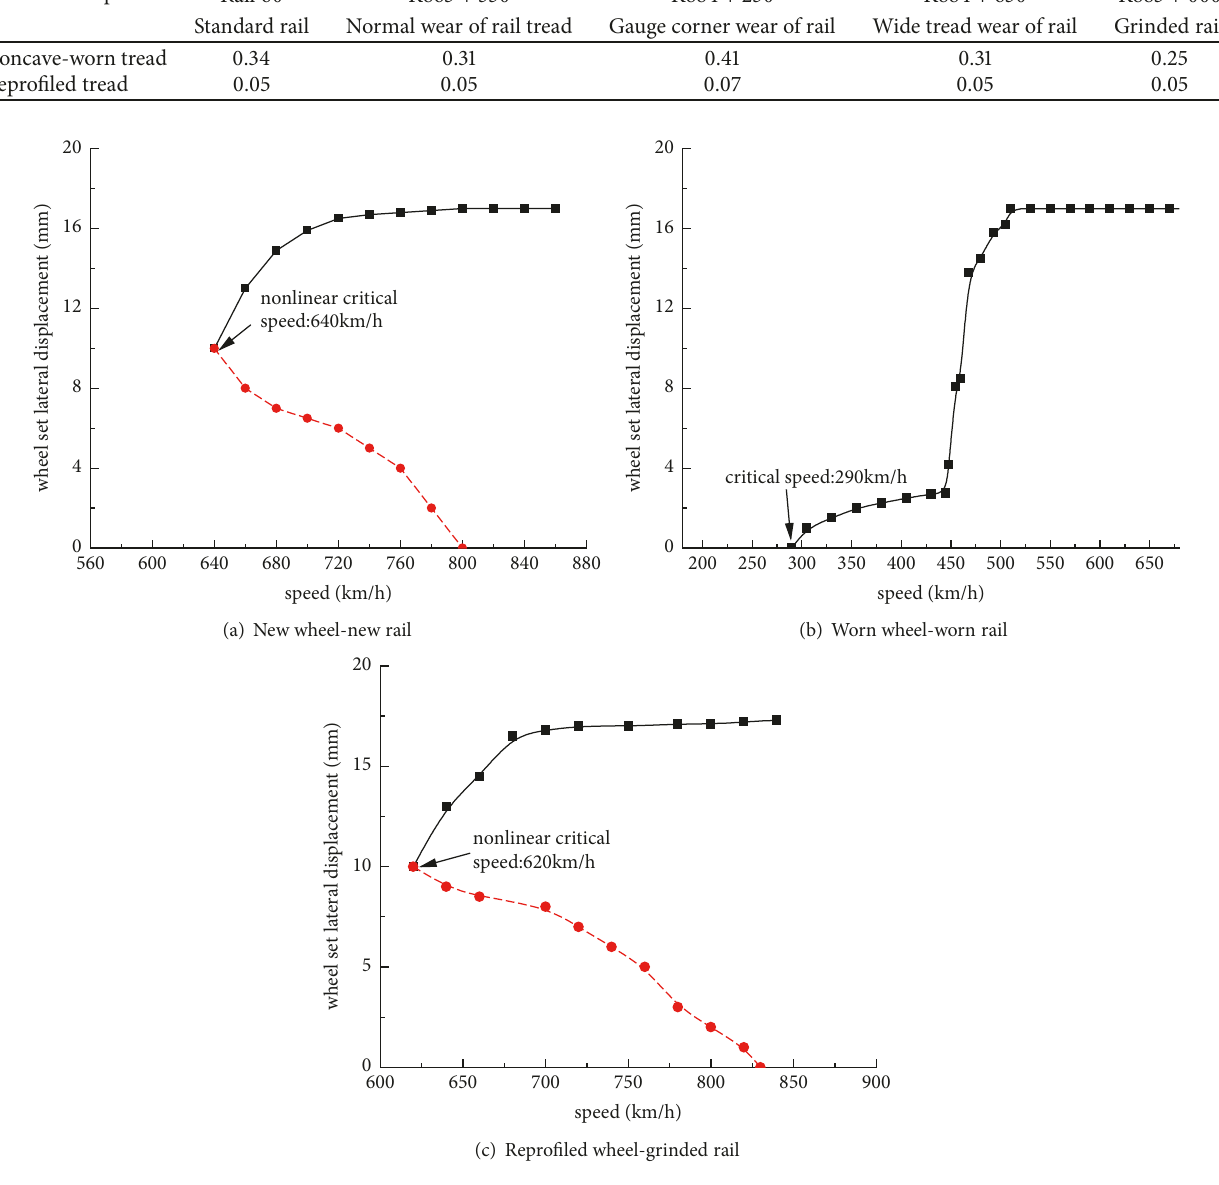
Figure 12: The effect of wheel-rail wear on nonlinear critical